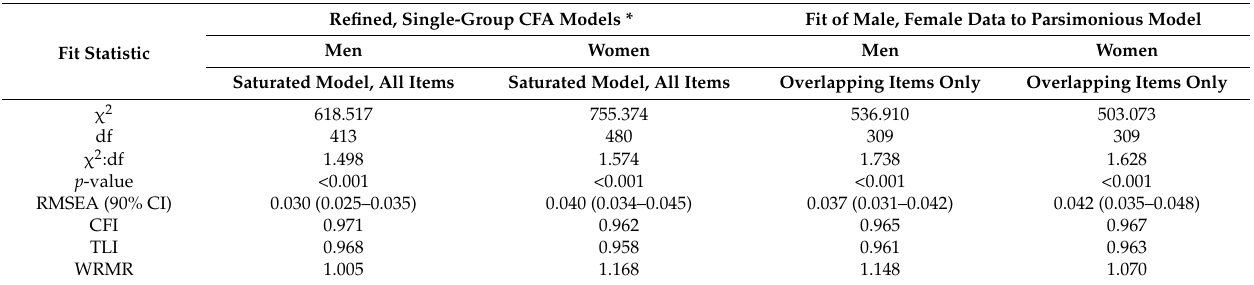
Table A5. Model Fit Statistics for CFA of Refined Single-Group and Parsimonious (Overlapping Items) Models. Refined, Single-Group CFA Models * Fit of Male, Female Data to Parsimonious Model Men Women Men Women Fit Statistic Saturated Model, All Items Saturated Model, All Items Overlapping Items Only Overlapping Items Only χ